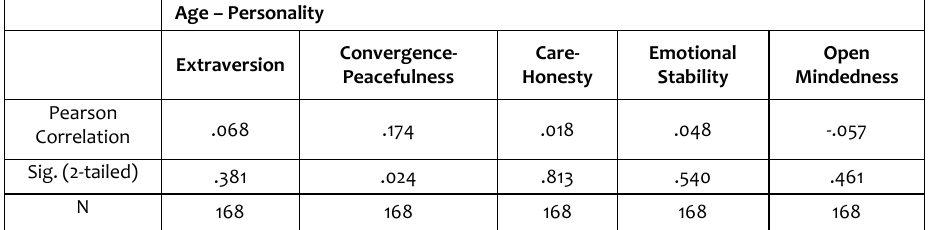
Table 2. Correlation Test for the Connection between Personality Traits and Age of Visually Impaired Athletes who participated in the study Age – Personality Convergence- Care- Emotional Open Extraversion Peacefulness Honesty Stability Mindedness Pearson Correlation .068 .174 .018 .048 -.057 Sig. (2-tailed) .381 .024 .813 .540 N 168 168 168 168